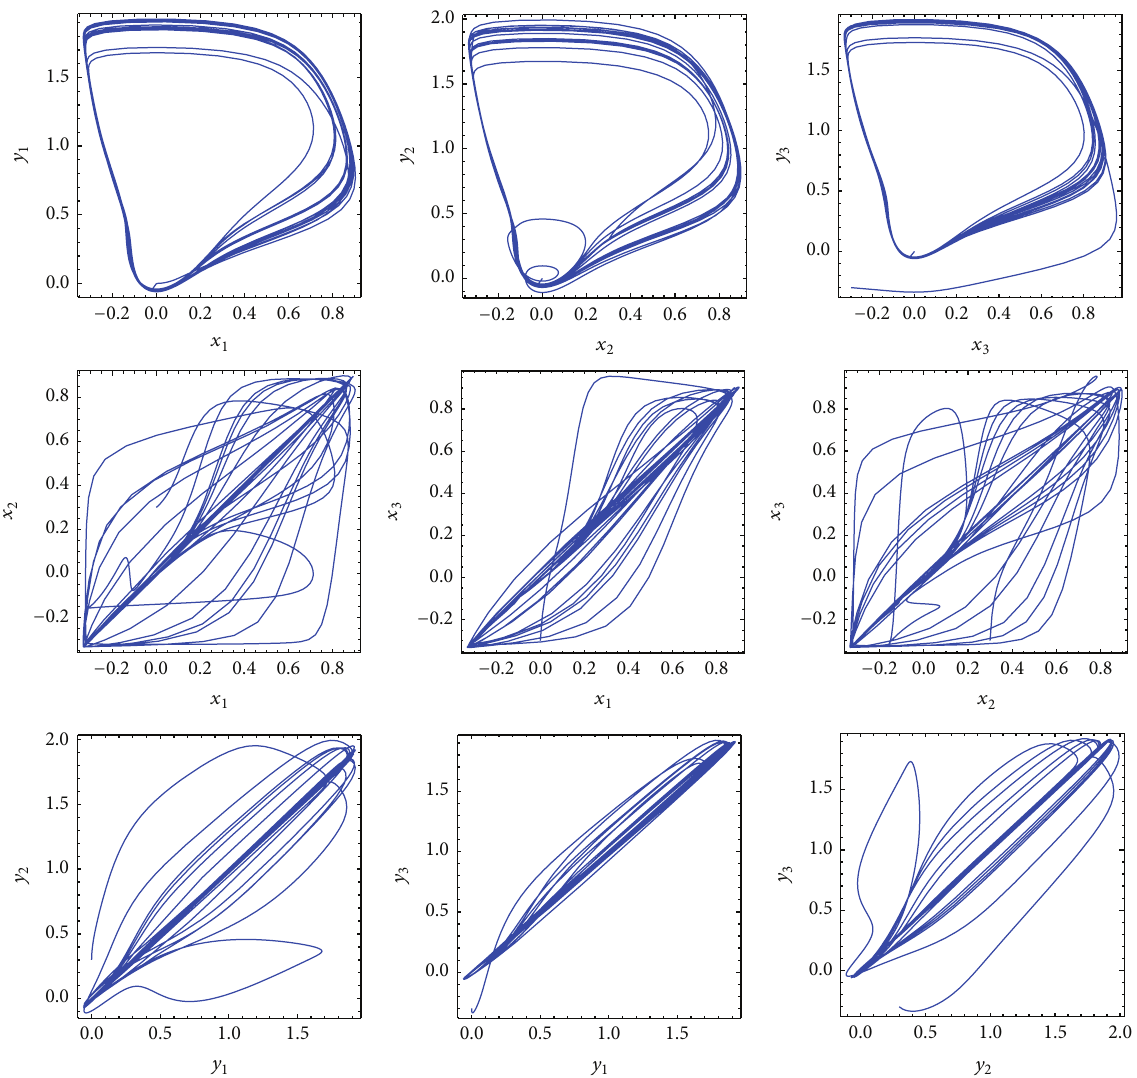
Figure 3: Phase plot of chaotic behavior of chaotic FHN neuromsis, with 𝛼 1 = 𝛼 3 = 𝛼 5 = 0.9, 𝛼 2 = 𝛼 4 = 𝛼 6 = 0.8